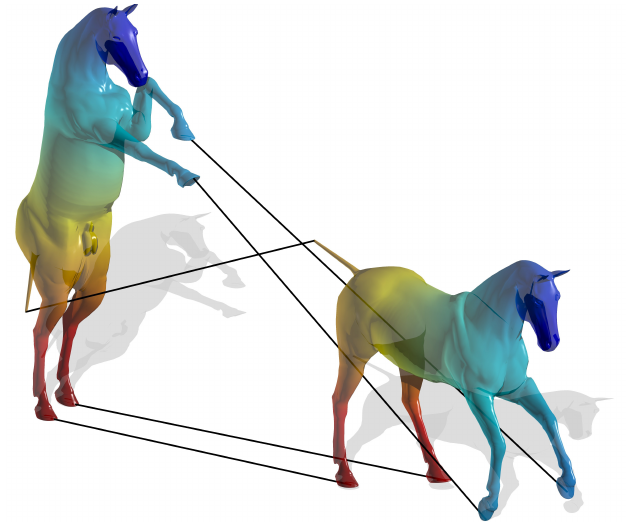
Figure 6. Feature point correspondence of two nearly isometric shapes of a